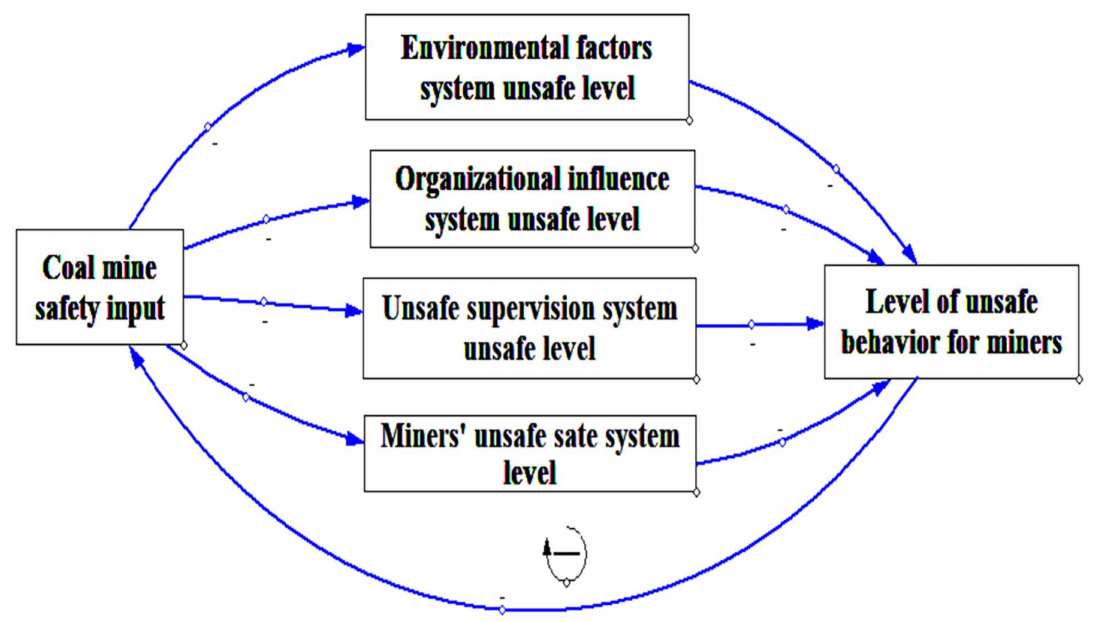
Figure 5. Causal cycle diagram of management of deep coal miner’s unsafe